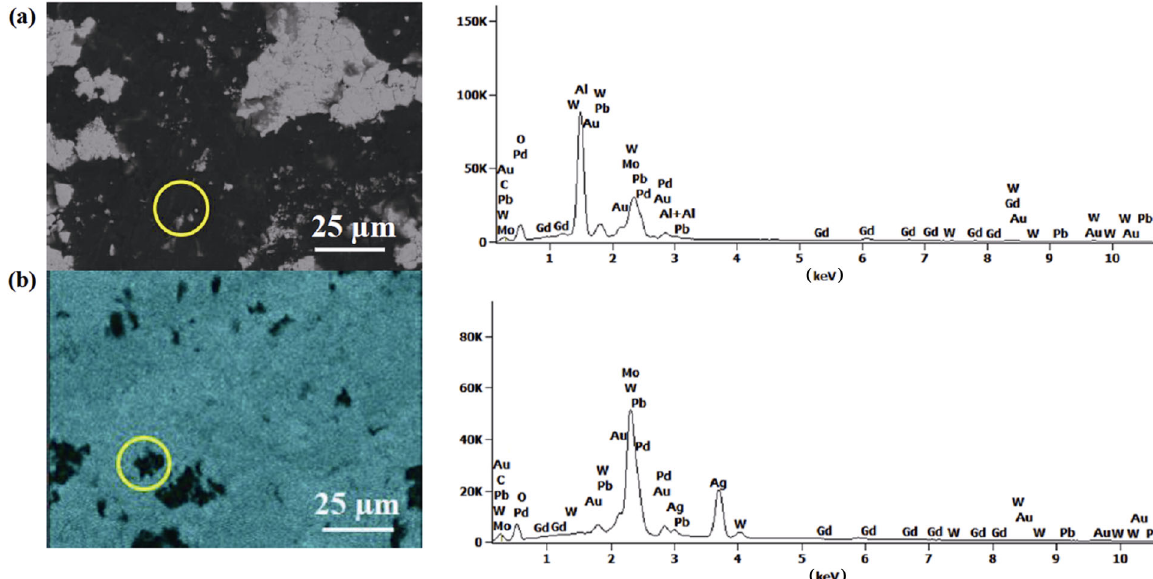
Fig. 4 BSE micrographs and EDS spectra of Gd 3+ -doped samples ( x = 0.0839) mixed with (a) 30 wt% Al (black grains—Al; gray grains—Gd 3+ -doped sample), (b) 30 wt% Ag (black grains—Ag; emerald grains—Gd 3+ -doped sample) and co-fired at 873